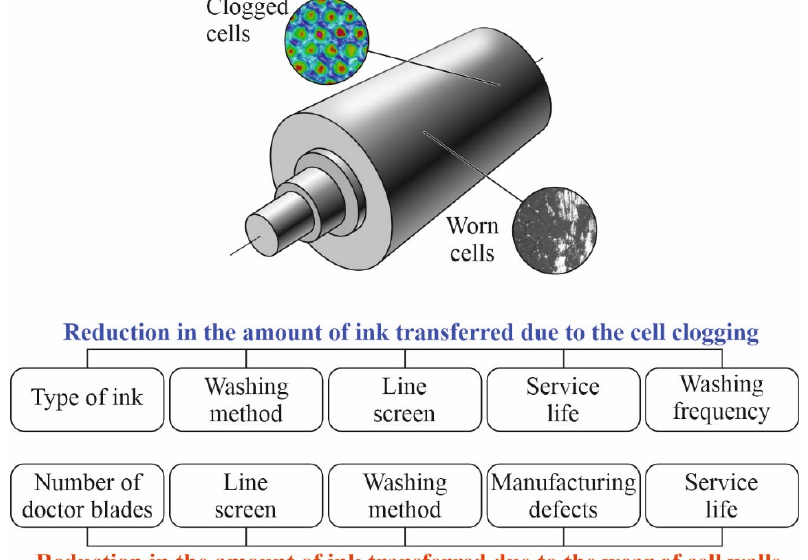
Figure 2. Factors influencing the reduction of ink transfer.